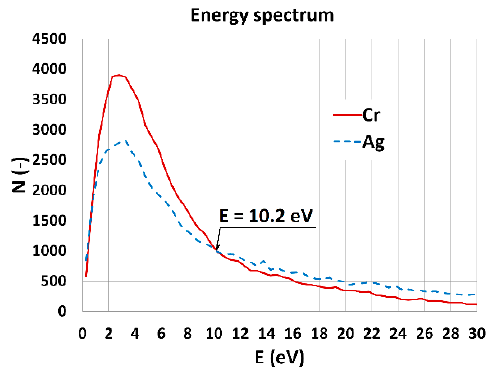
Figure 8. The simulated energy spectrum of secondary electrons for a chromium and silver specimen, primary beam energy E P = 1 keV.